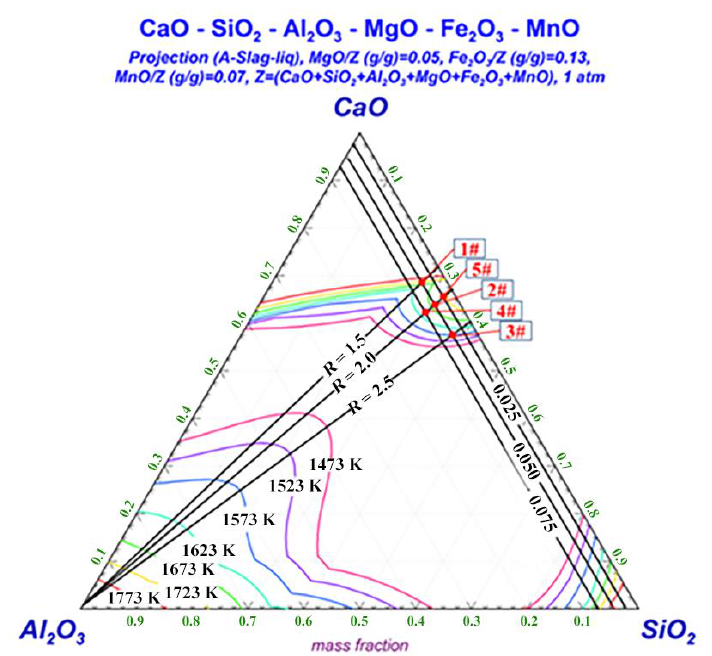
Figure 5. Phase diagram of CaO-SiO 2 -Al 2 O 3 -5%MgO.